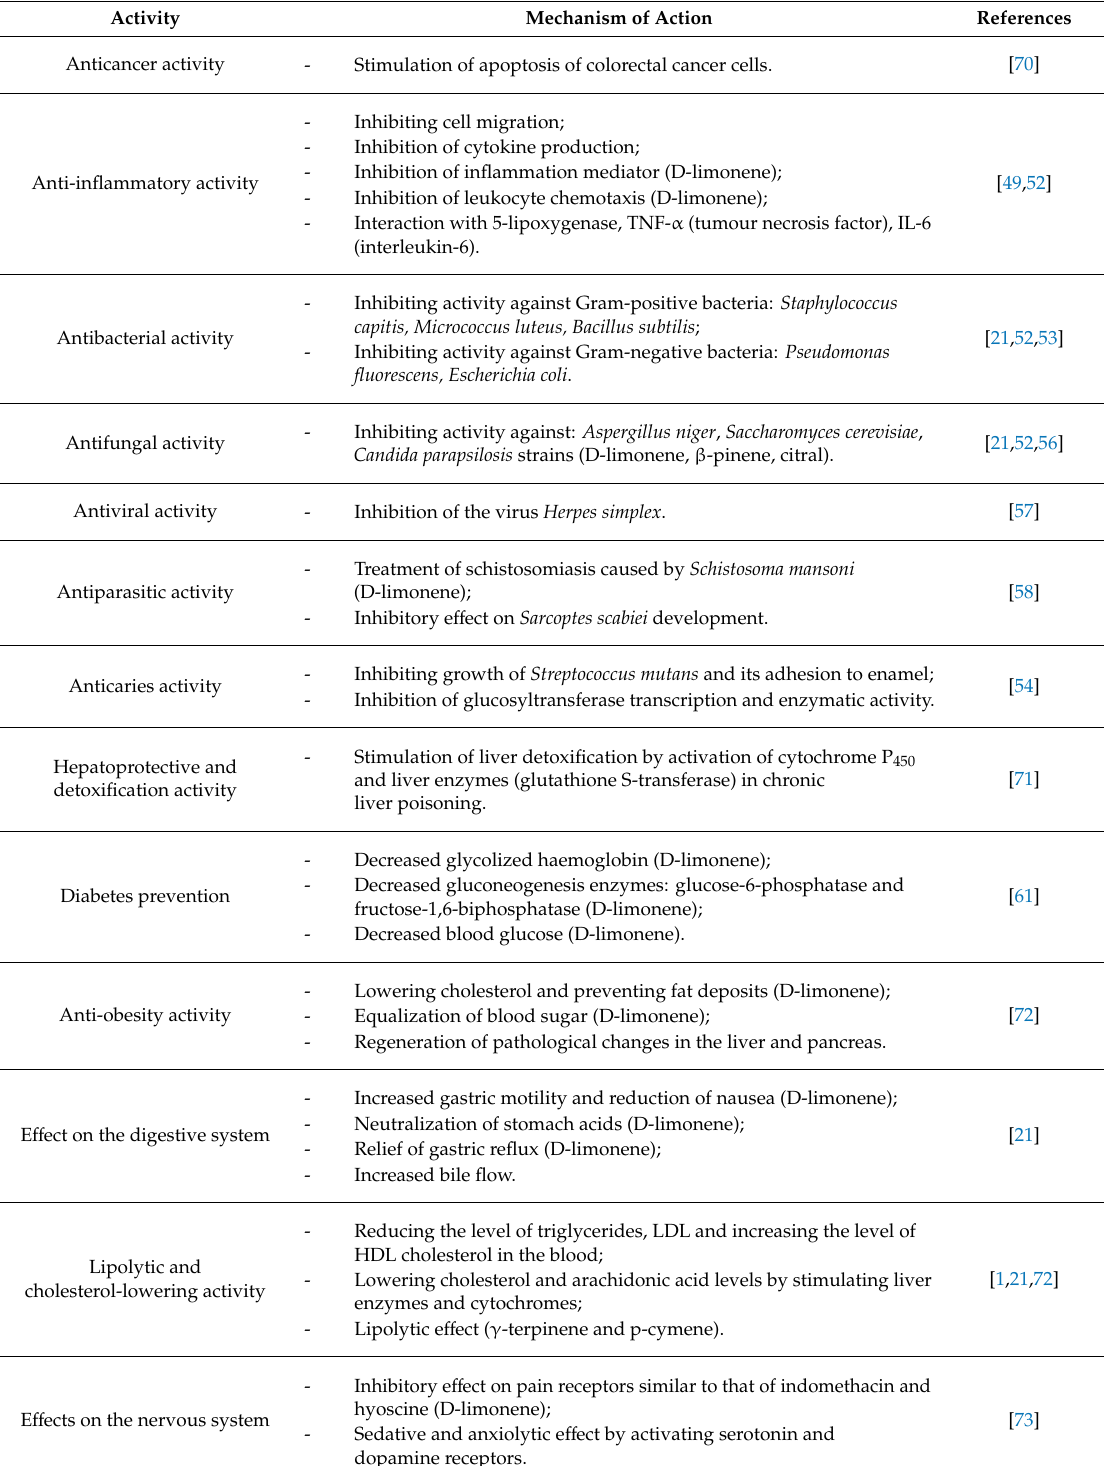
Table 8. Biological activity of C. limon essential oil confirmed by scientific